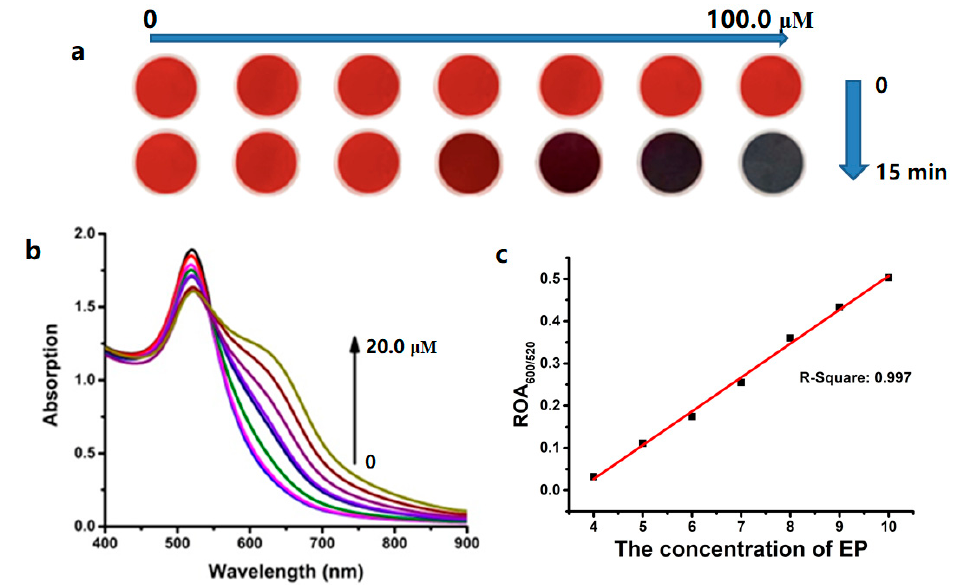
Figure 7. ( a ) The colorimetric and ( b ) absorption changes of RB-AuNPs in various amounts of ethoprophos. ( c ) The linear fitting of ROA 600/520 based on RB-AuNPs in the range of 4.0–10.0 µM ethoprophos.